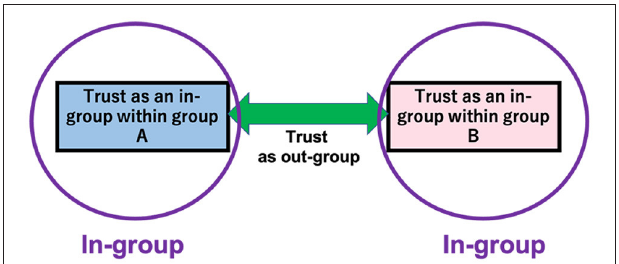
FIGURE 3 | Calculation result for N = 300. D ij for every persons are set to be random numbers between − 1 to +1. FIGURE 4 | Model of social division in the